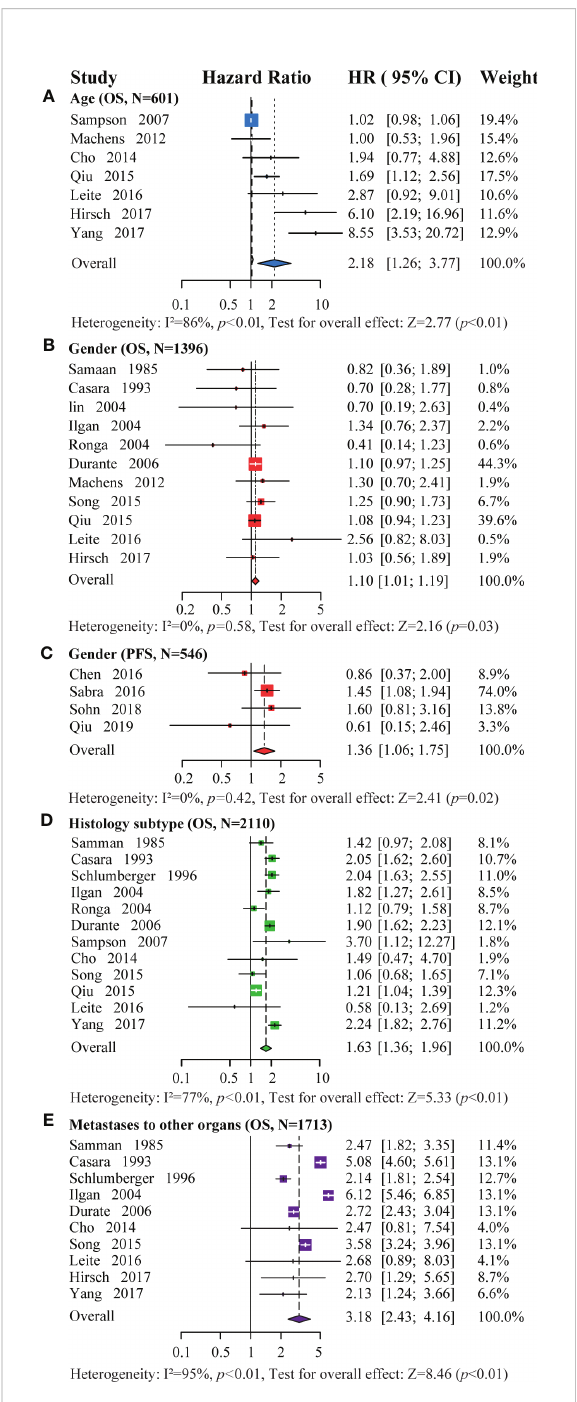
FIGURE 2 Forest plot for the association of: (A) age with OS (>45 years vs. ≤ 45 years), (B) gender with OS (male vs. female), (C) gender with PFS (male vs. female), (D) histology subtype with OS (FTC vs. PTC), and (E) metastases to other organs with OS (with vs.